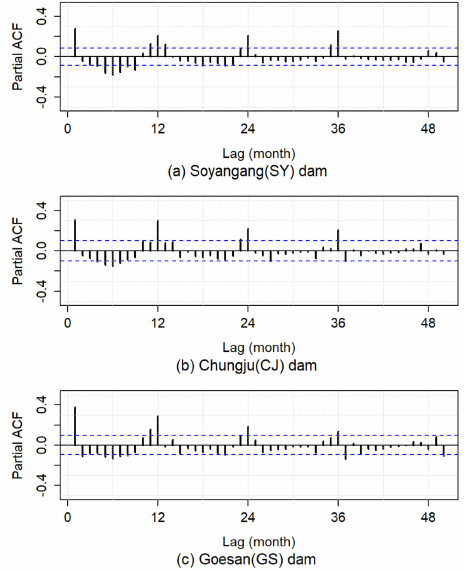
Figure 6. Partial Autocorrelation Function (PACF) of the three dams with 95% confidence intervals (dotted line): ( a ) SY dam, ( b ) CJ dam, ( c ) GS